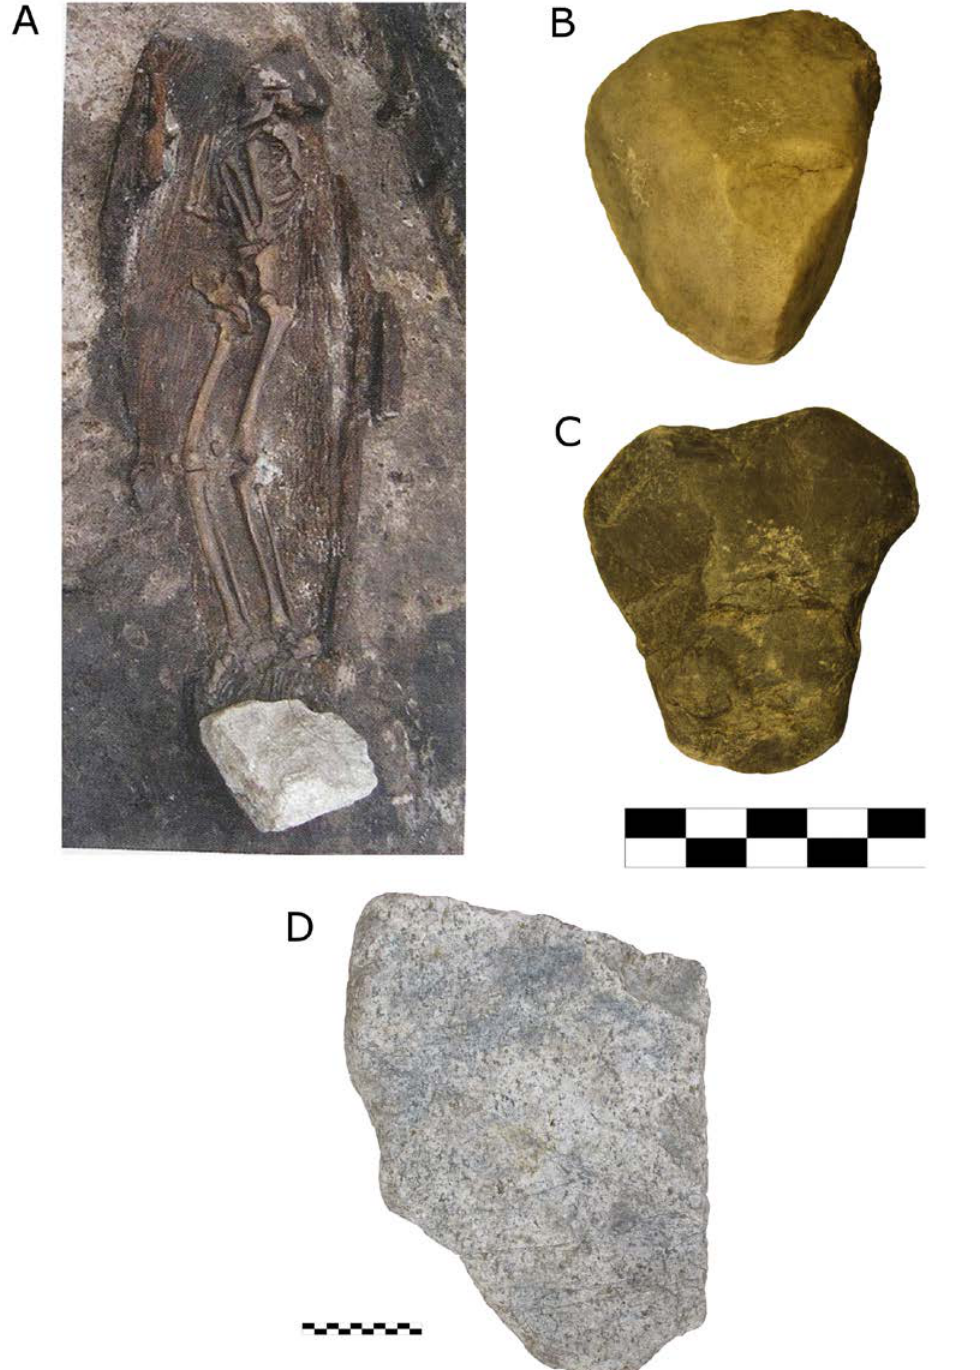
Figure 10. A) Grave found in the wetland area of Bruszczewo in which macro-lithic artefacts were given as the only grave goods in this context (taken from Kneisel et al. 2012: 22). B-C) macro-lithic artefacts made of quartzite and used for multiple purposes according to their use-wear traces. D) stoneslab made of granite, found at the feet of the deceased. This finding represents the only funerary context known in Bruszczewo so